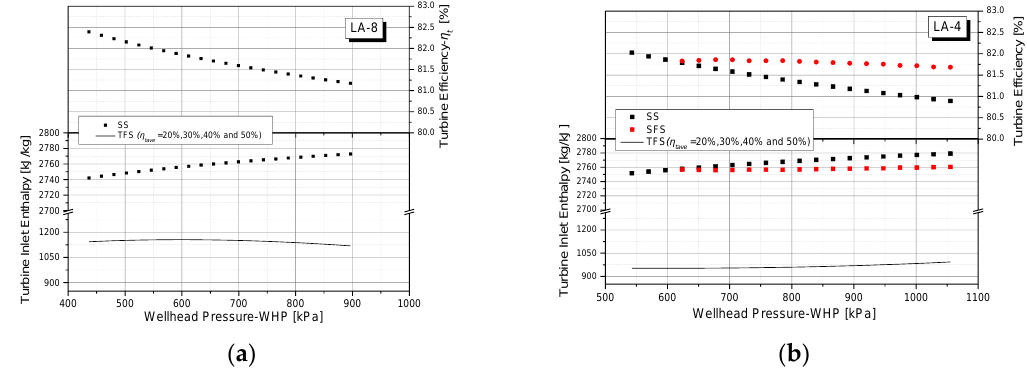
Figure 3. Turbine e ffi ciency and turbine inlet thermodynamic state of ( a ) LA-8 and ( b ) Figure 3. Turbine efficiency and turbine inlet thermodynamic state of ( a ) LA-8 and